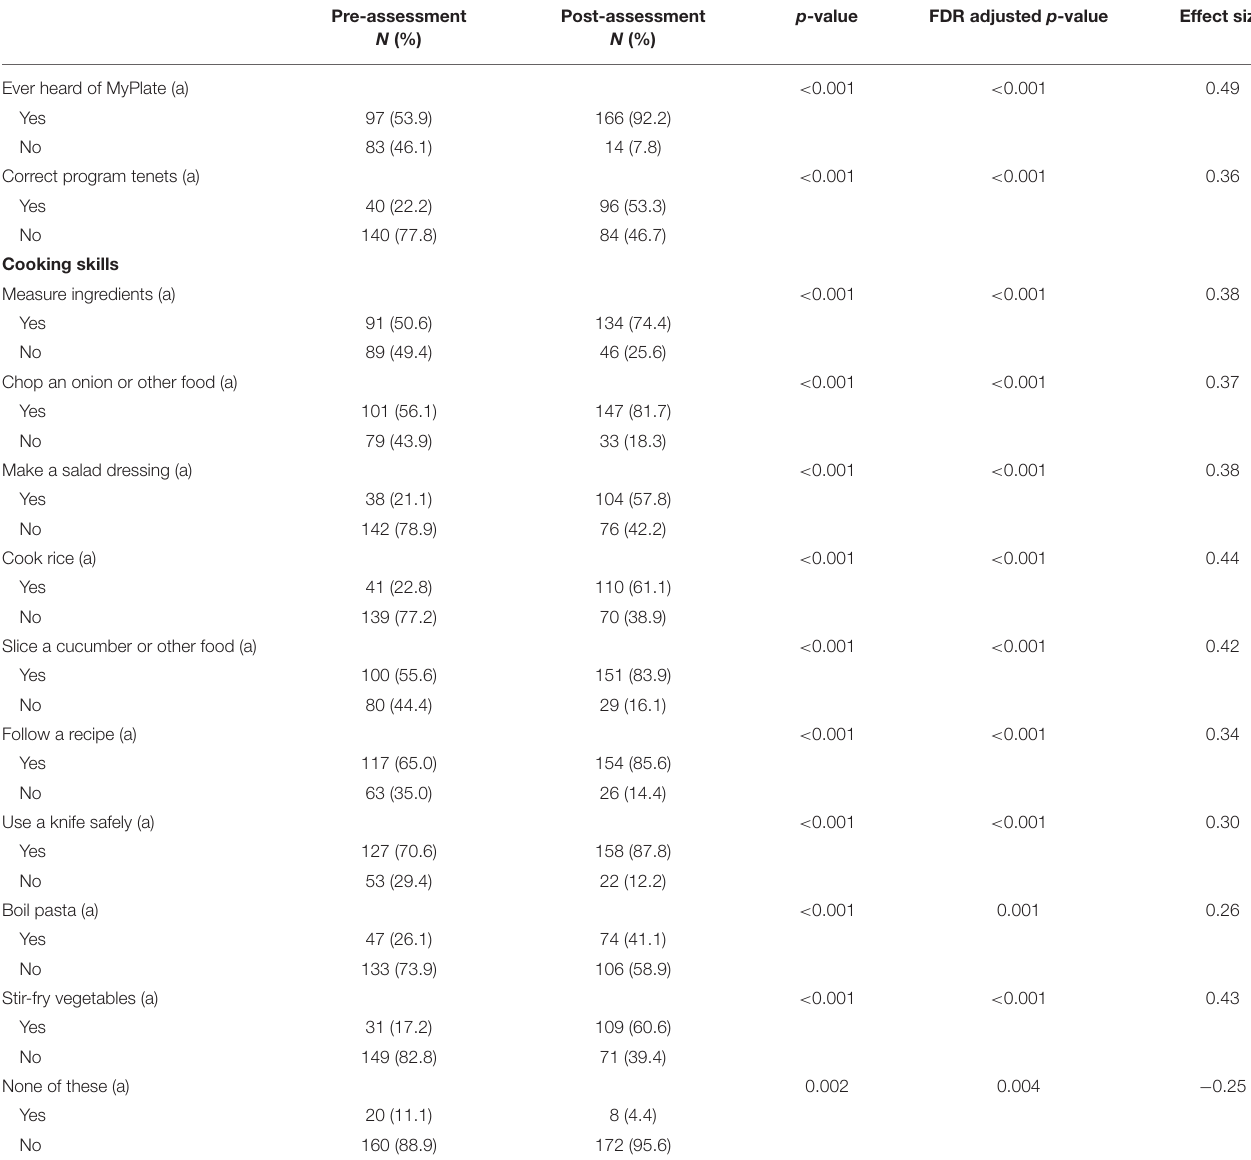
TABLE 3 | Changes in knowledge and skills among children who completed both pre- and post-assessment surveys ( n = 180). Pre-assessment N